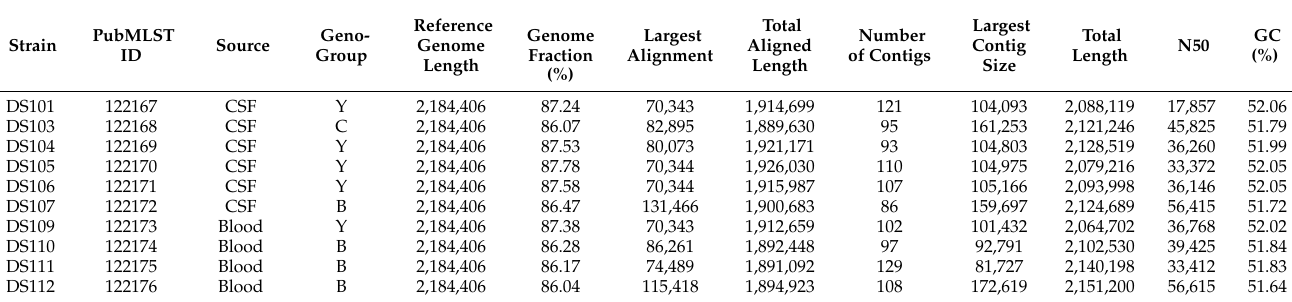
Table 3. Outcome of targeted DNA enrichment and whole genome sequencing of N. meningitidis from dried clinical